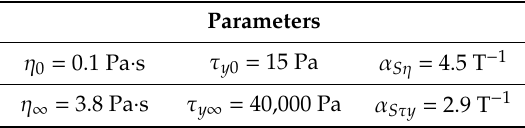
Table 2. Rheological properties of the magnetorheological (MR) fluid 132-DG.